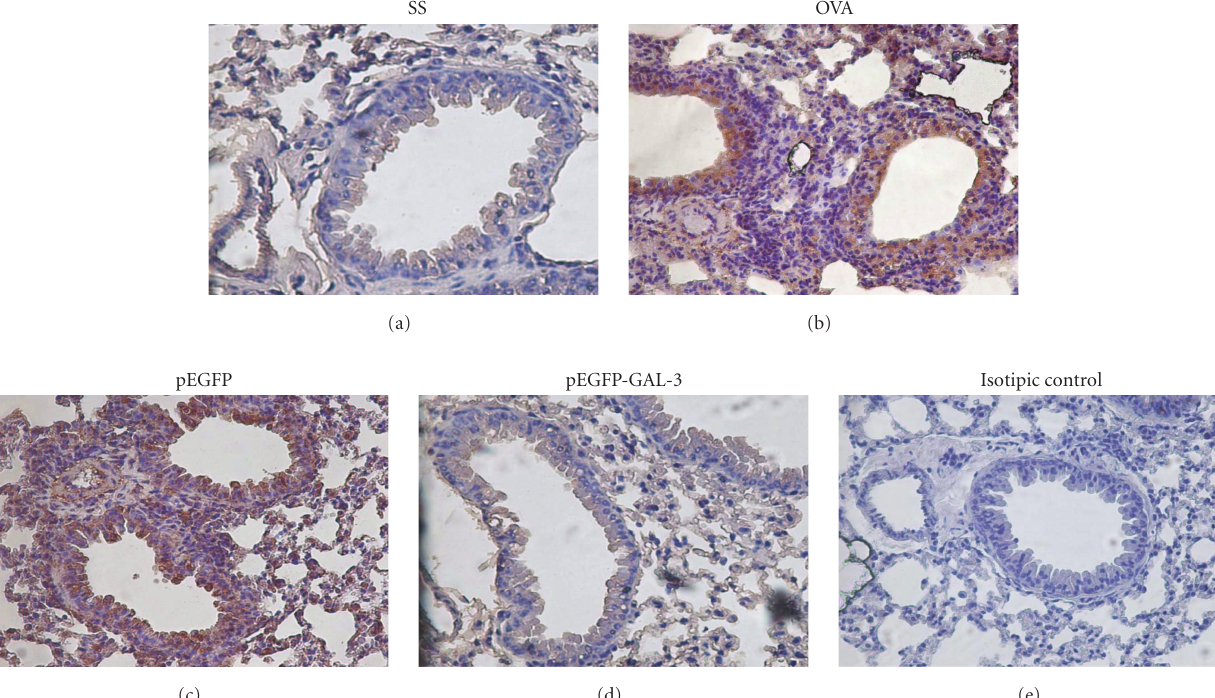
Figure 4: Immunohistochemical expression of SOCS-3 in lung tissue from A/J mice. (a) Saline control group (untreated). (b) Positive control group (OVA group) with chronic allergic airway inflammation. (c) pEGFP group, OVA immunized animals treated with empty plasmid. (d) pEGFP-Gal-3 group, OVA immunized animals treated with plasmid encoding Gal-3. (e) Control using normal goat IgG instead of goat anti-SOCS3 antibody. The picture is a representative example of 5 mice, all displaying similar